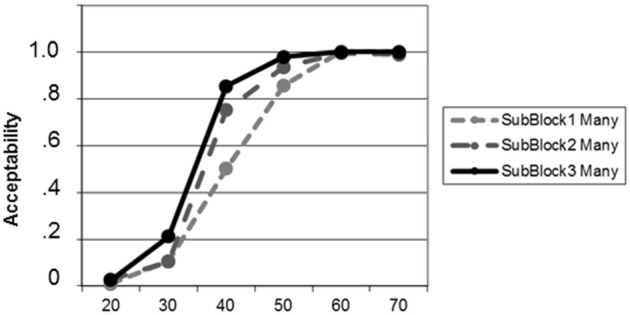
Learning curves for the new meaning of “many” during the adaptation phase (block 2) as a function of percent circles of the target color, plotted separately for each of the three sub-blocks. The learning effect at the trained proportion “40” is visible.